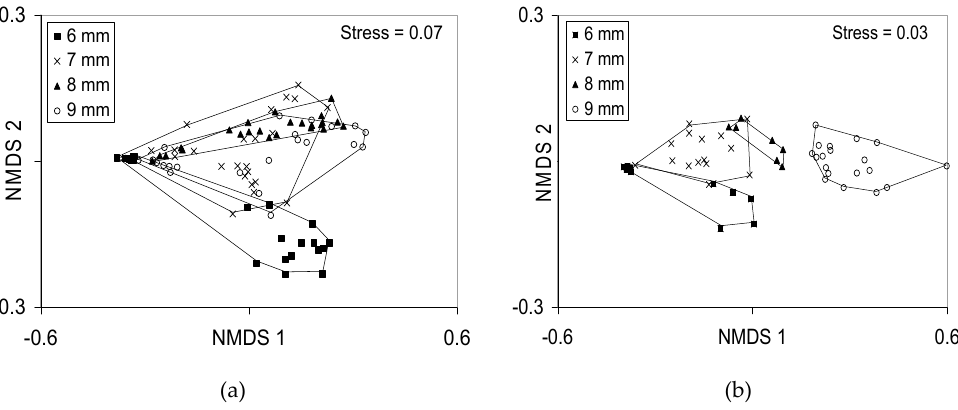
Figure 11. ( a ) Cleared and stained larvae and juveniles with alcian blue (cartilage) and alizarin red (bone) for Río Cabuyo fish sized 5–9 mm SL. ( b ) Each specimen was imaged at high magnification so that each of 111 skeletal elements could be scored for degree of ossification on a scale of 1–4. Photos by Tony Stumbo. Data from [17].